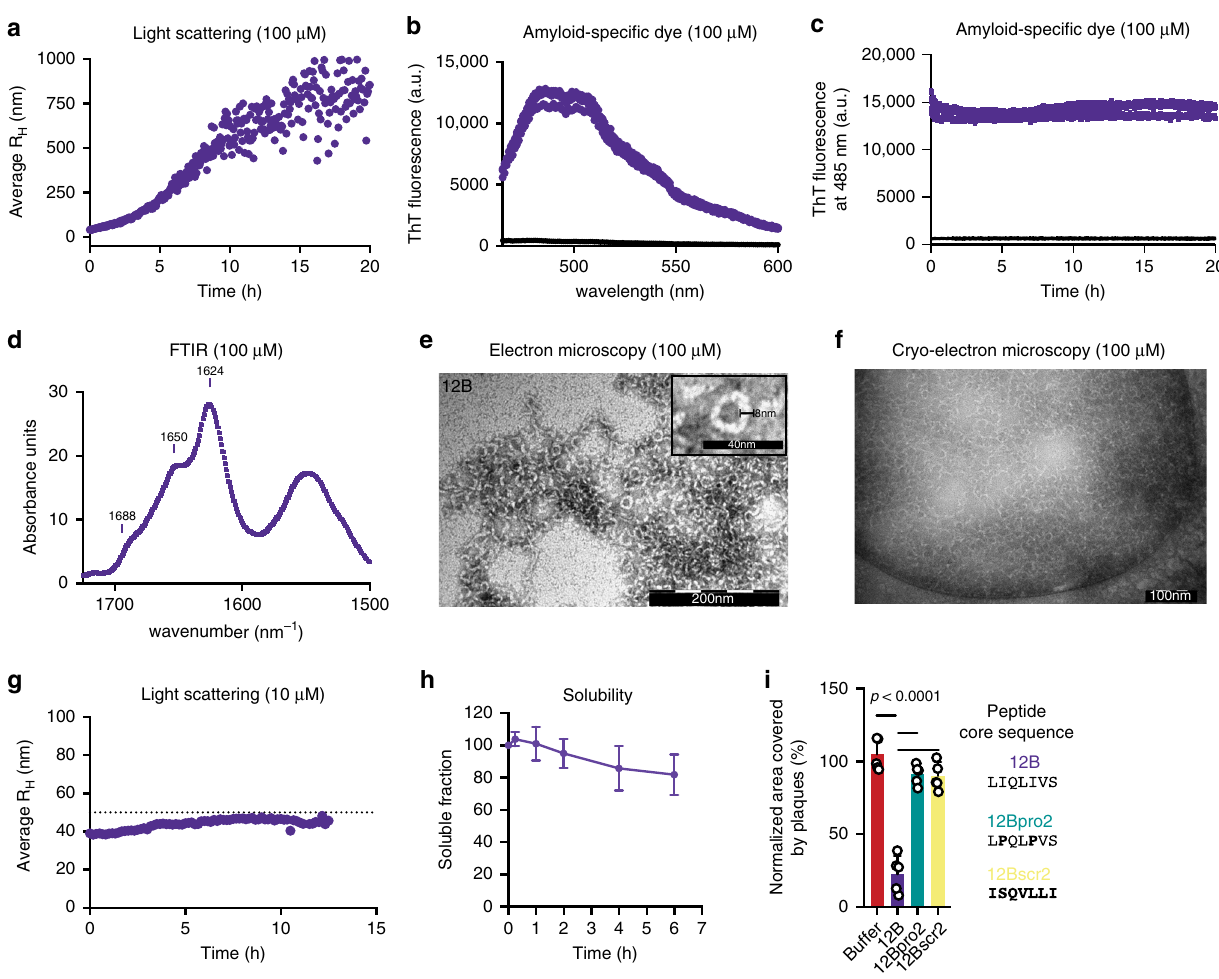
Fig. 2 Peptide 12B organizes into amyloid-like structures in vitro. a Hydrodynamic radius ( R H ) calculated from the regularization fi t of DLS data of peptide 12B (100 µ M) maturation over time. b Th-T emission spectrum after excitation at 440 nm of buffer (black line) or peptide 12B (100 µ M, purple line) 5 min after solubilization ( n = 3 independent experiments). c Th-T emission signal of buffer (black line) or peptide 12B (100 µ M, purple line) at 485 nm after excitation at 440 nm as a function of time. Data represent three independent repeats ( n = 3 independent experiments). d FTIR spectrum of 100 µ M peptide 12B 5 min after solubilization. TEM ( e ) and cryo-TEM ( f ) of 100 µ M freshly dissolved peptide 12B (both are one representative image of three independent experiments). g Hydrodynamic radius ( R H ) calculated from the regularization fi t of DLS data of peptide 12B (10 µ M) maturation over time (dashed line =